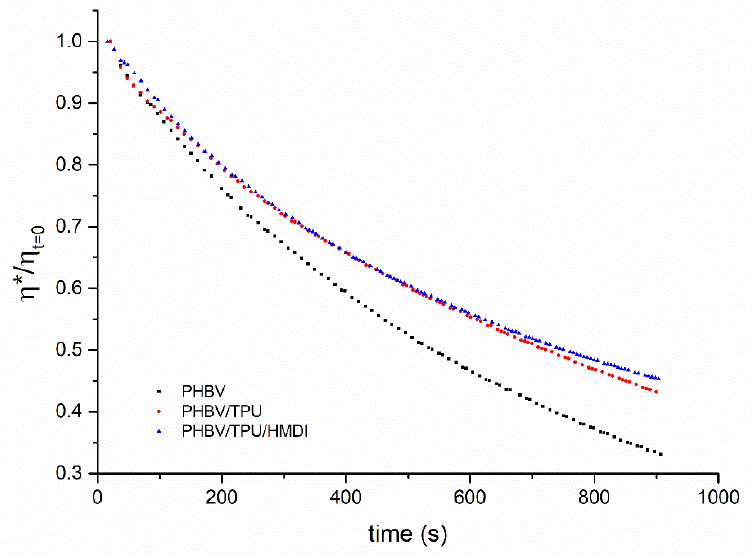
Figure 6. The normalized complex viscosity as a function of time of the neat PHBV and the PHBV/TPU blends.